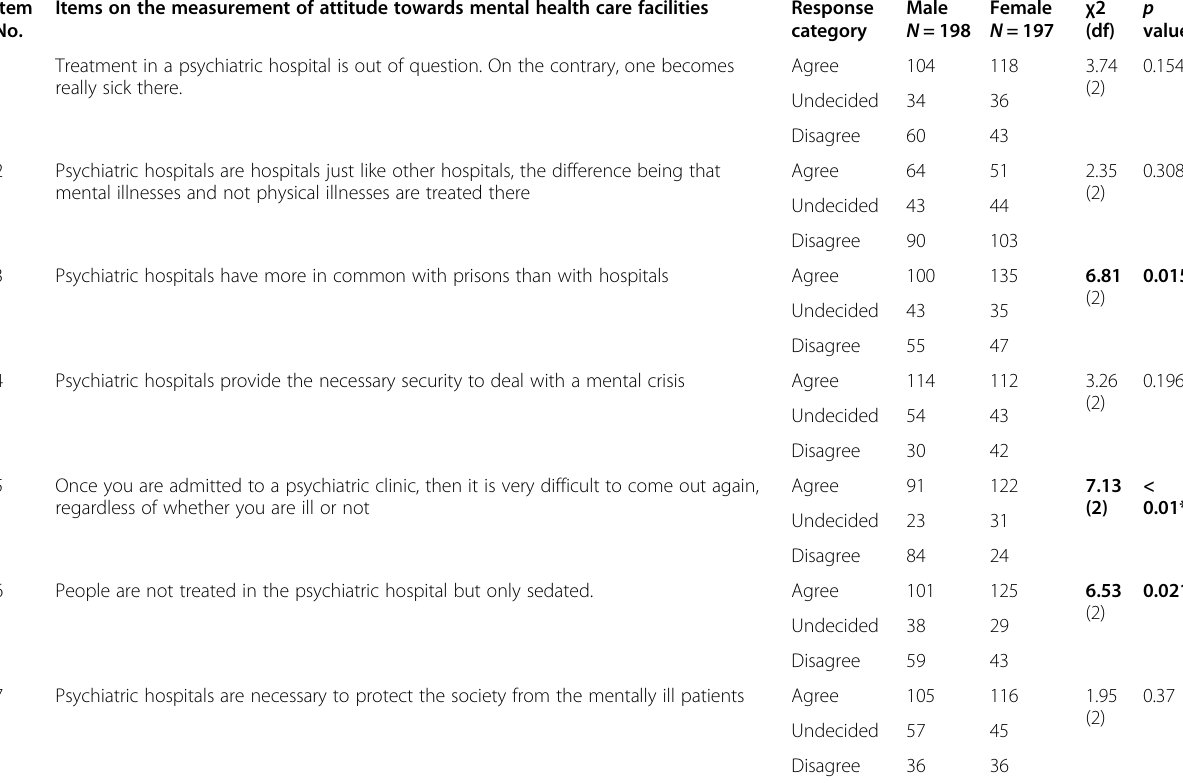
Numbers in parentheses indicate column percentages χ 2 Chi square test statistic, df degrees of freedom * p